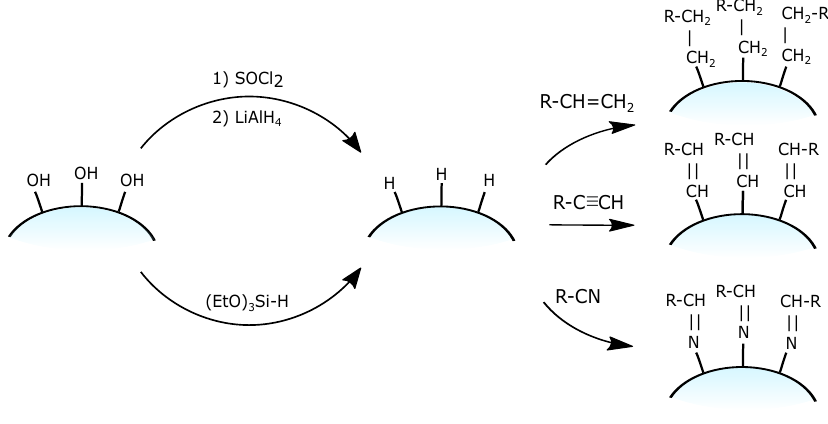
Figure 15. Grafting of a silica